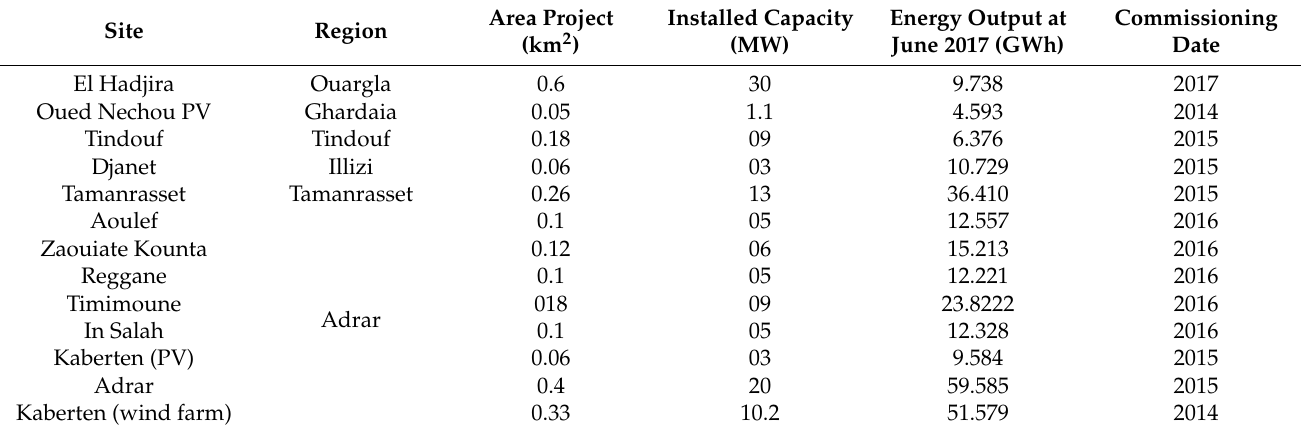
Table 11. Energy output and installed capacity of completed projects in Sahara [83].